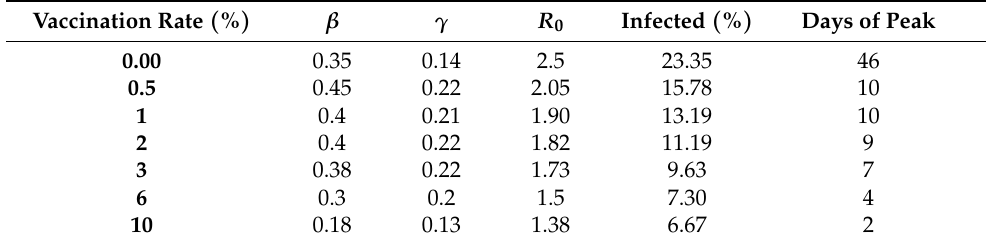
Table 2. Impact of vaccination with ( 80% )